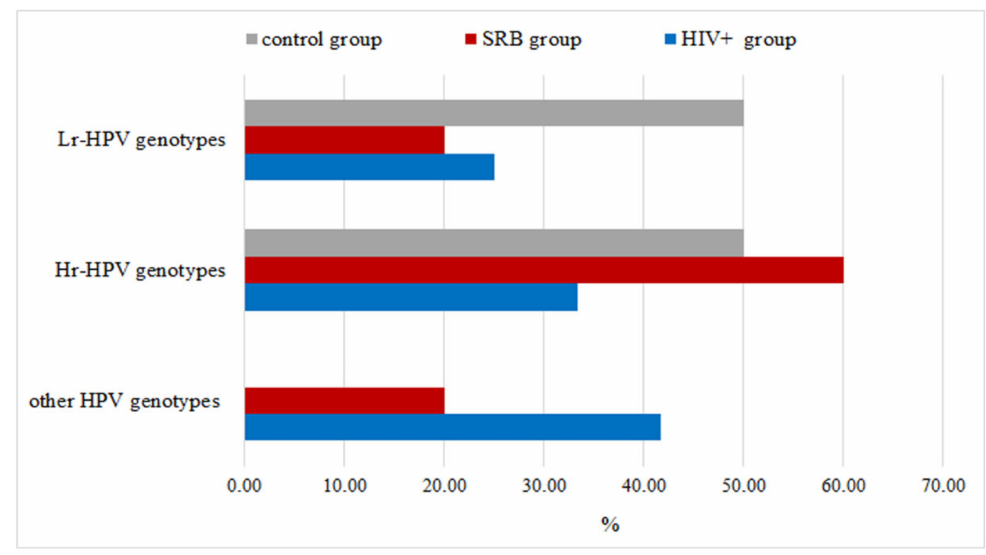
Figure 1. Percentage of oral HPV-positivity in the three considered groups.